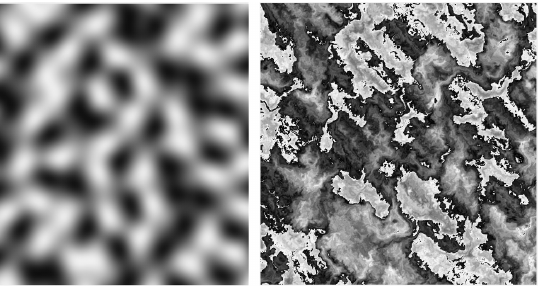
Figure 14. Sample SimplexNoise noise (on the left ) and noise transformed with function (1) (on the right ).